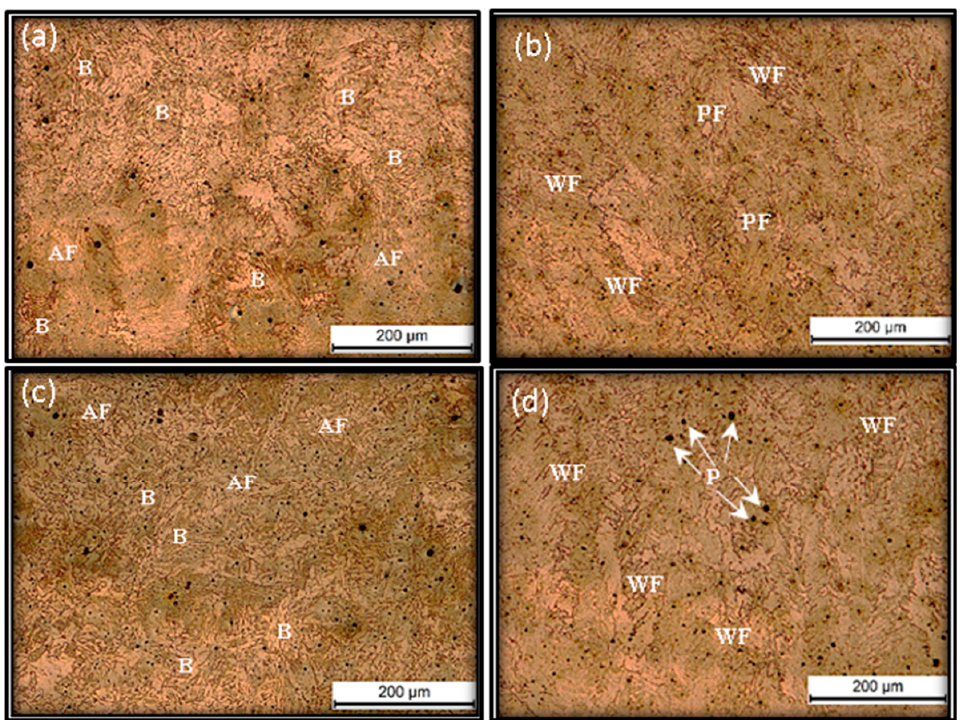
Figure 13. OM images for WAAM-ed prismatic blocks built at ( a , c ) Block 130; ( b , d ) Block 330 for the 2nd and 3rd layers, respectively.